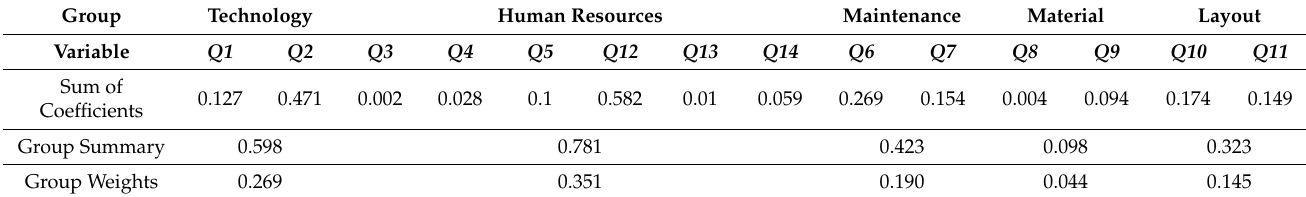
Table 5. Coefficients of variables for